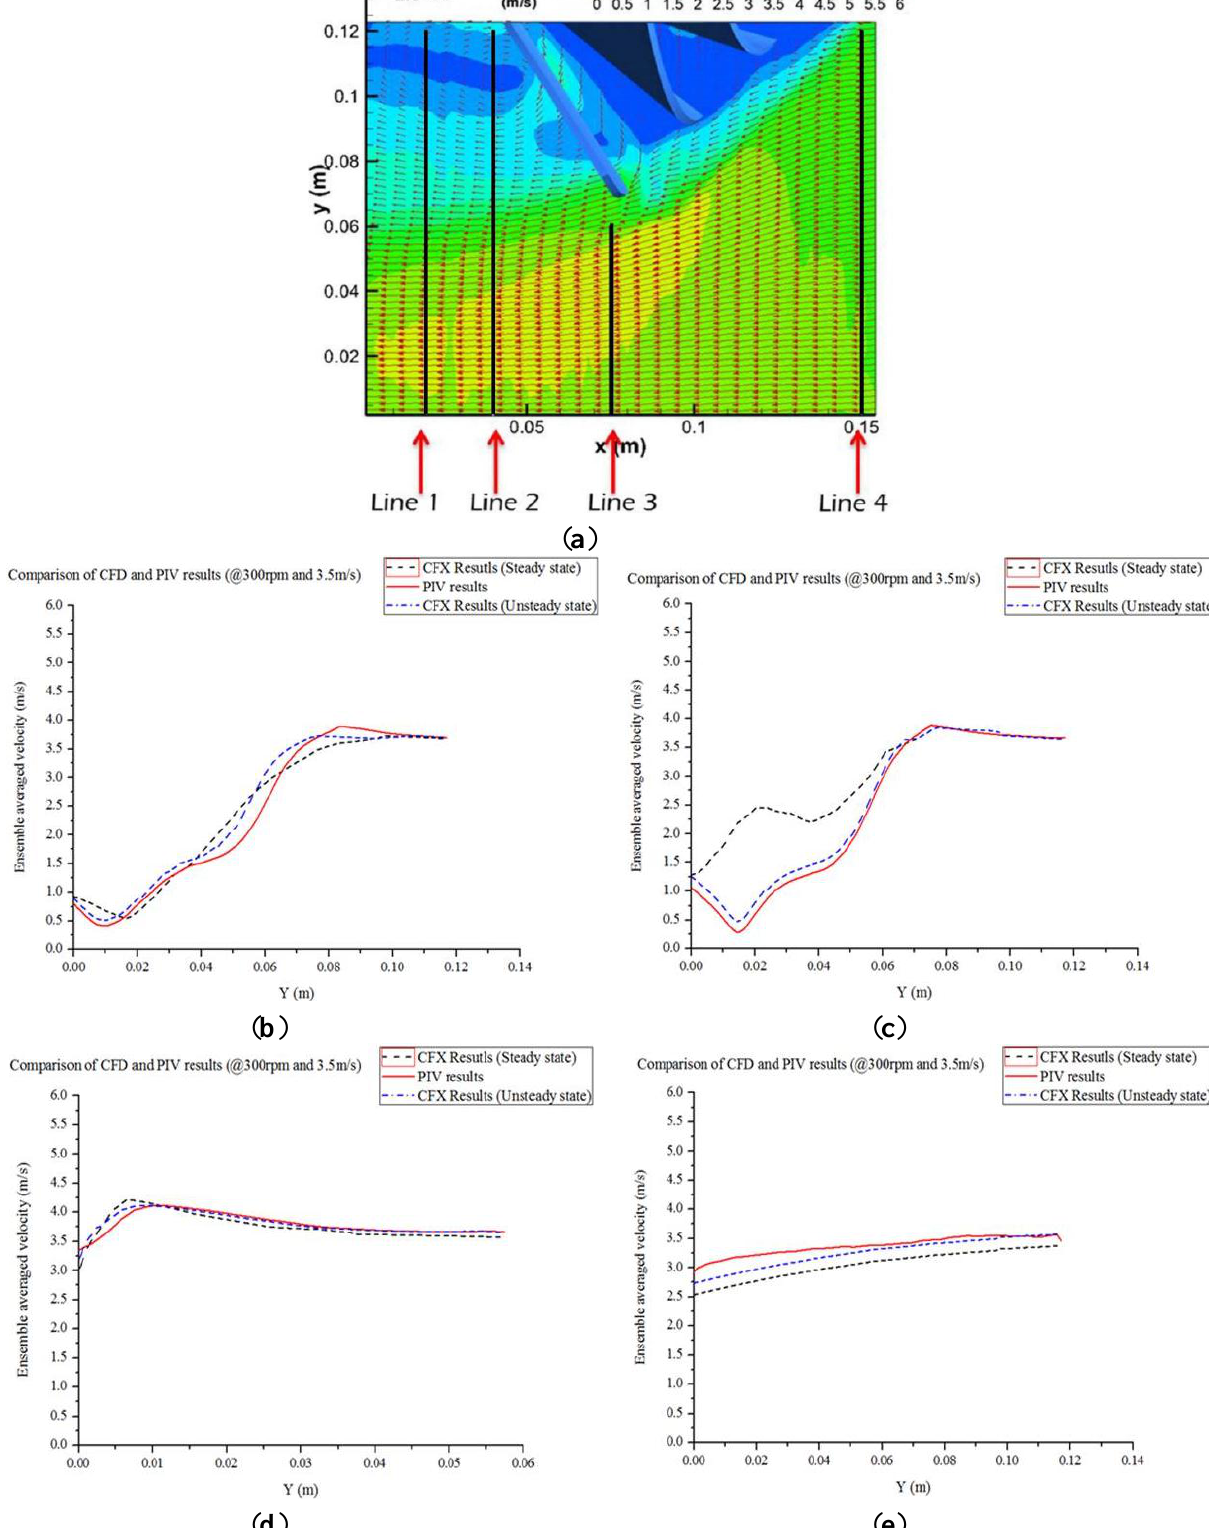
Figure 14. Comparison of the PIV experimental and CFD (steady and unsteady state) results (300 rpm and U∞ = 3.5 m/s). ( a ) Line Data Extracting Location for the Velocity Profile; ( b ) Velocity Profile at Line 1; ( c ) Velocity Profile at Line 2; ( d ) Velocity Profile at Line 3; ( e ) Velocity Profile at Line